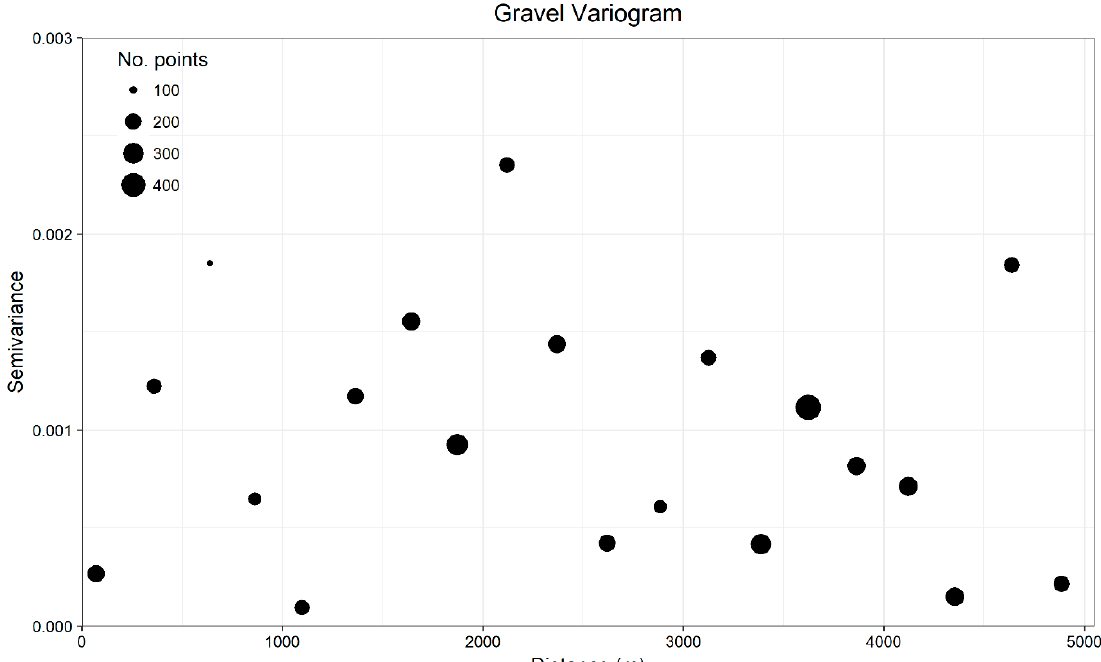
Figure A4. Coarse substrate variogram circular model with 360 m lags; nugget = 0.0603, partial sill = 0.0786, major range = 199.12 m. Appendix D Error Matrices Because the leave-one-out cross-validations (including spatial leave-one-out) produce a prediction for each sample point in the dataset, error matrices can be calculated between observed and predicted sediment classes for each sample. Note a slight difference in observed grain size classes